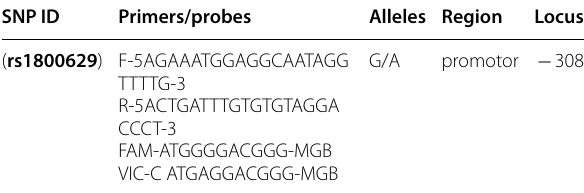
Table 1 P -value of TNF-alpha (pg/ml) concentration among studied subjects